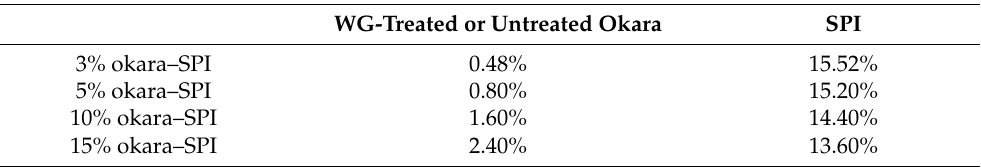
Figure 6. Schematic diagram of the preparation procedure for okara-soybean protein isolate (SPI) gels. Table 1. Concentrations of wet-type grinder (WG)-treated or untreated okara and soybean protein isolate (SPI) for the preparation of okara–SPI